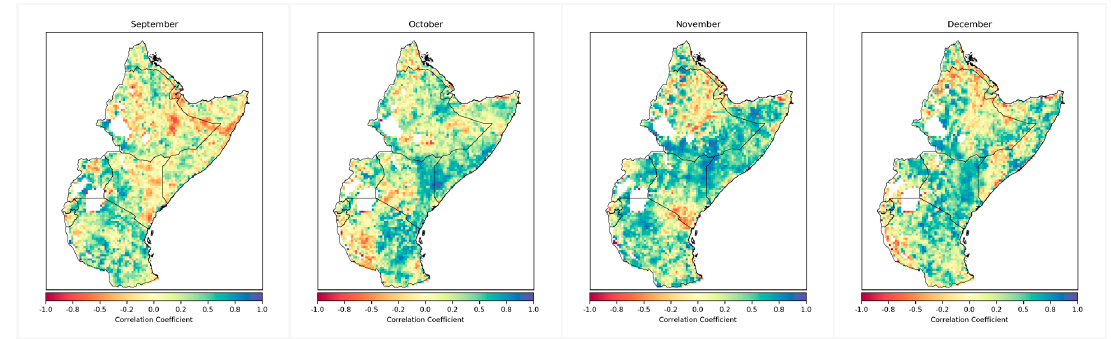
Figure A4. Pearson correlation coefficient for monthly soil-moisture estimates and the ESI (2003–2016); soil moisture lagged by one month.